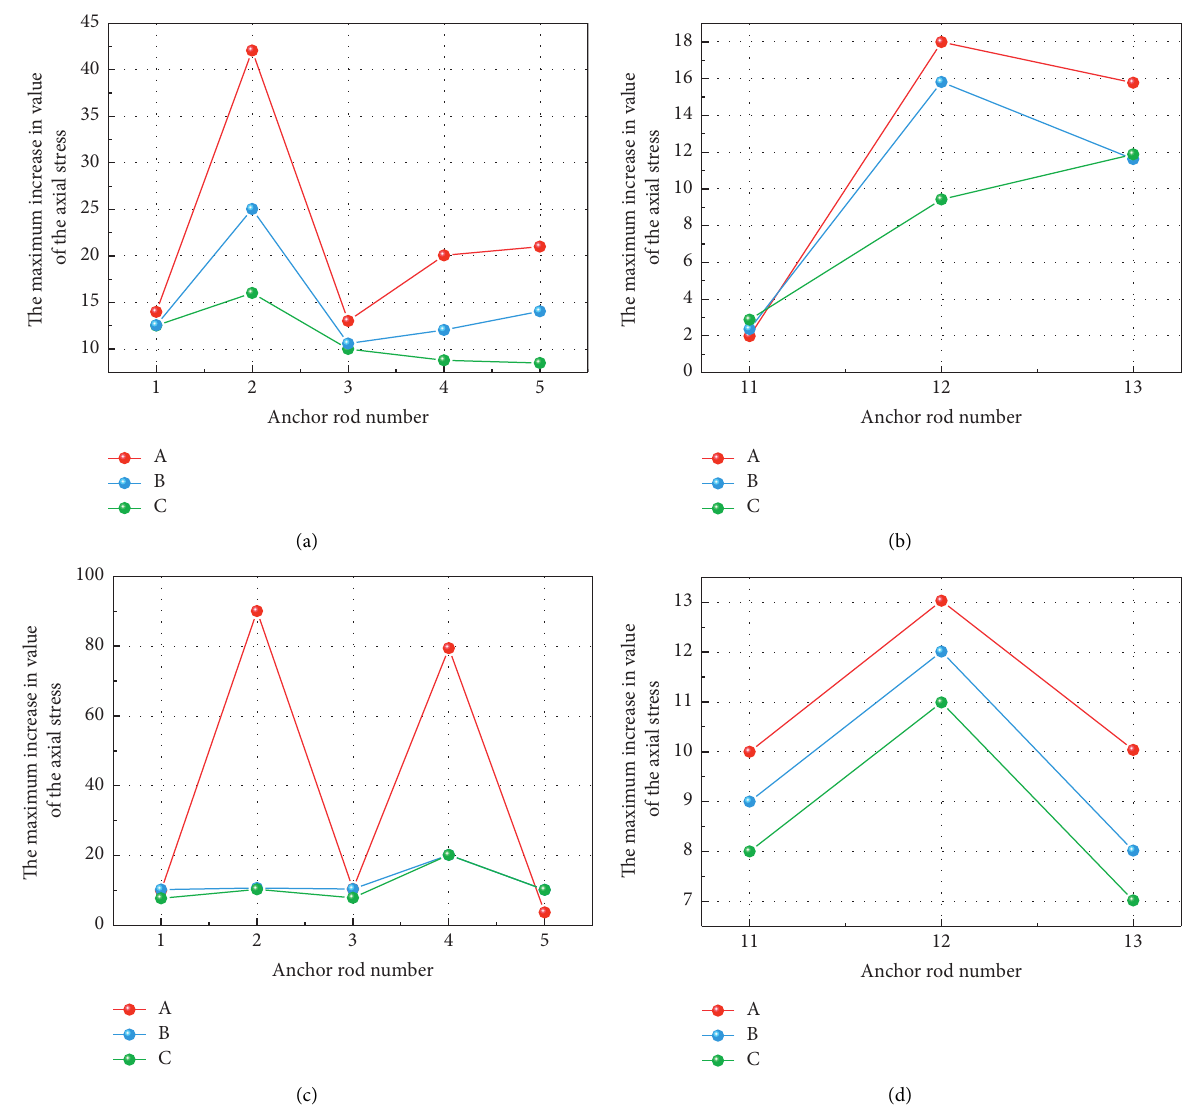
Figure 11: Comparison of stress and strain values of each section of bolt after earthquake: (a) maximum increment value of axial stress in each section of bolt at walls of roadway; (b) maximum increment value of axial stress in each section of bolt at roof of roadway; (c) axial strain value of walls of roadway after mine earthquake; (d) axial strain value of bolt at roof of roadway after mine